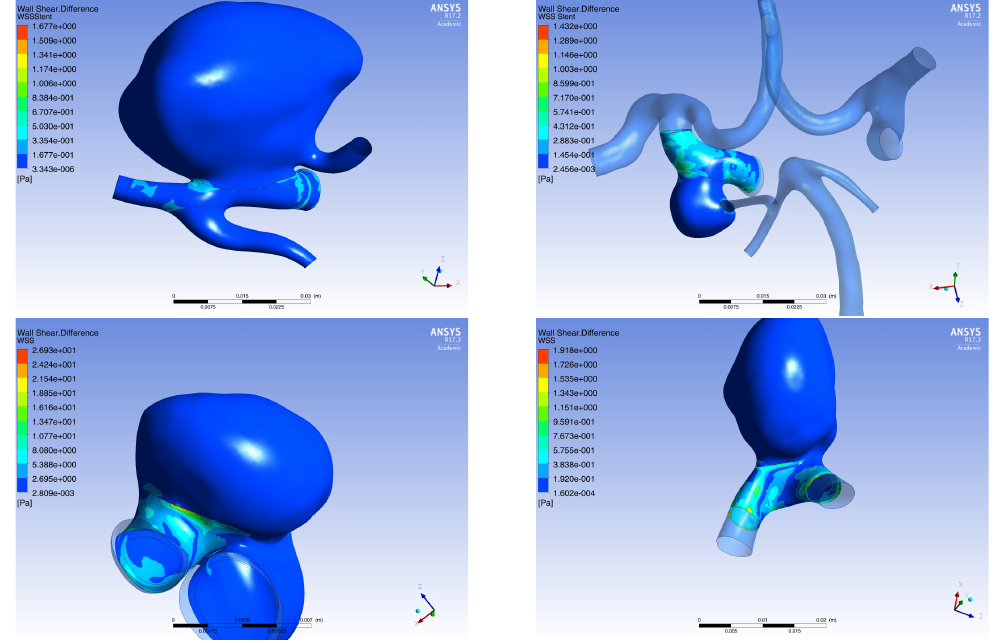
Figure 9. Distribution of ∆ WSS at time point t 2 : First line: (on the left ) Patient 1, (on the right ) Patient 2; Second line: (on the left ) Patient 3, (on the right ) Patient